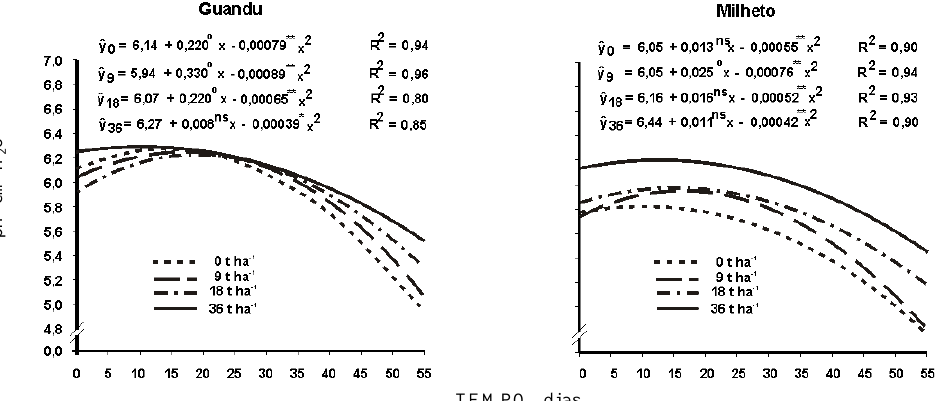
Figura 4. pH do Latossolo Vermelho argiloso afetado pelo tempo de incubação e doses crescentes de feijão guandu e milheto. ns , º , * , ** , *** : não-significativo e significativos a 10, 5, 1 e 0,1 %, respectivamente.